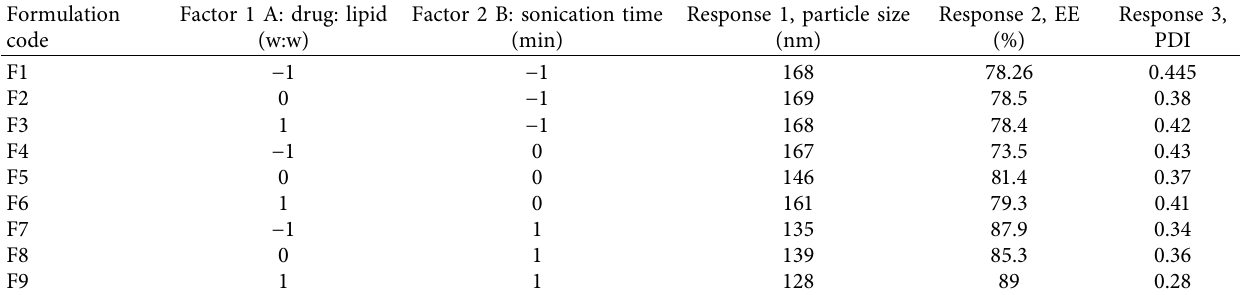
Table 2: DOE batches with results of particle size (nm), entrapment efficiency (%), and polydispersity index.